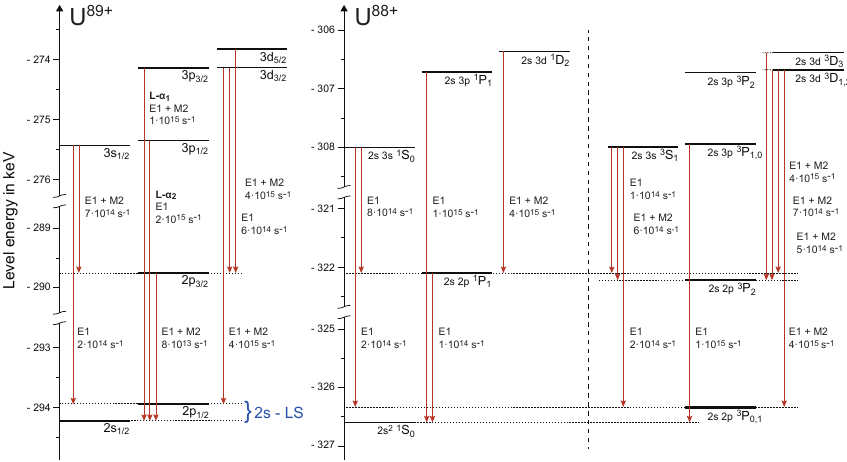
Figure 5. The two level schemes show the energy of the bound states of lithium-like ( left ) and beryllium-like uranium ( right ). Additionally, the X-ray transitions observed during the experiment are marked in the level